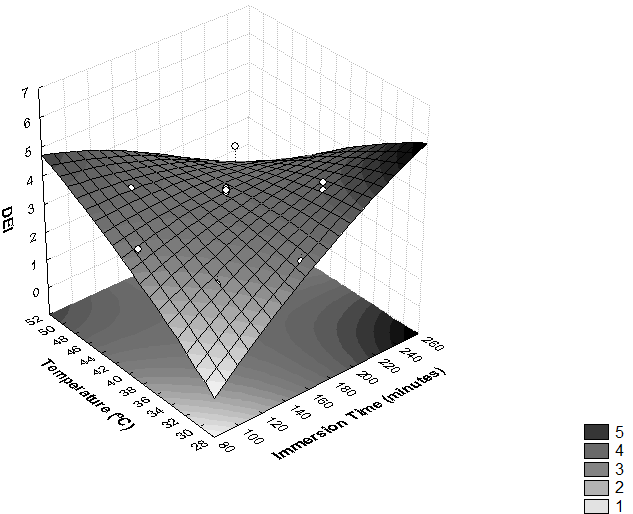
Figure 5. Surface response for Dehydration Efficiency Index (DEI) as a function of immersion time (minutes) and temperature (°C).